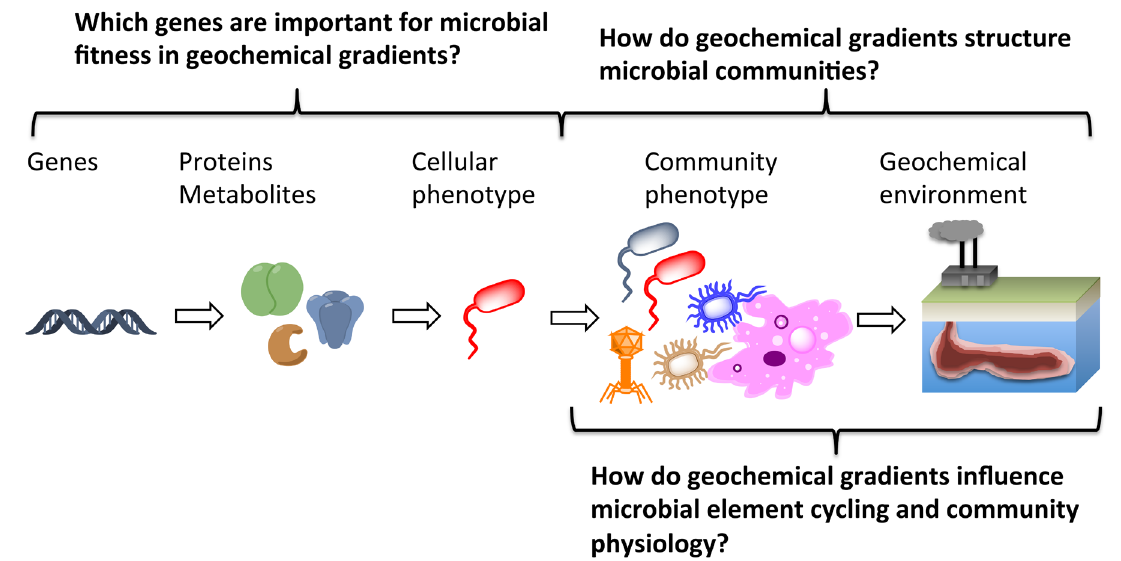
Figure 1. Understanding mechanisms whereby microorganisms survive in geochemical gradients is a central goal of environmental microbiology.